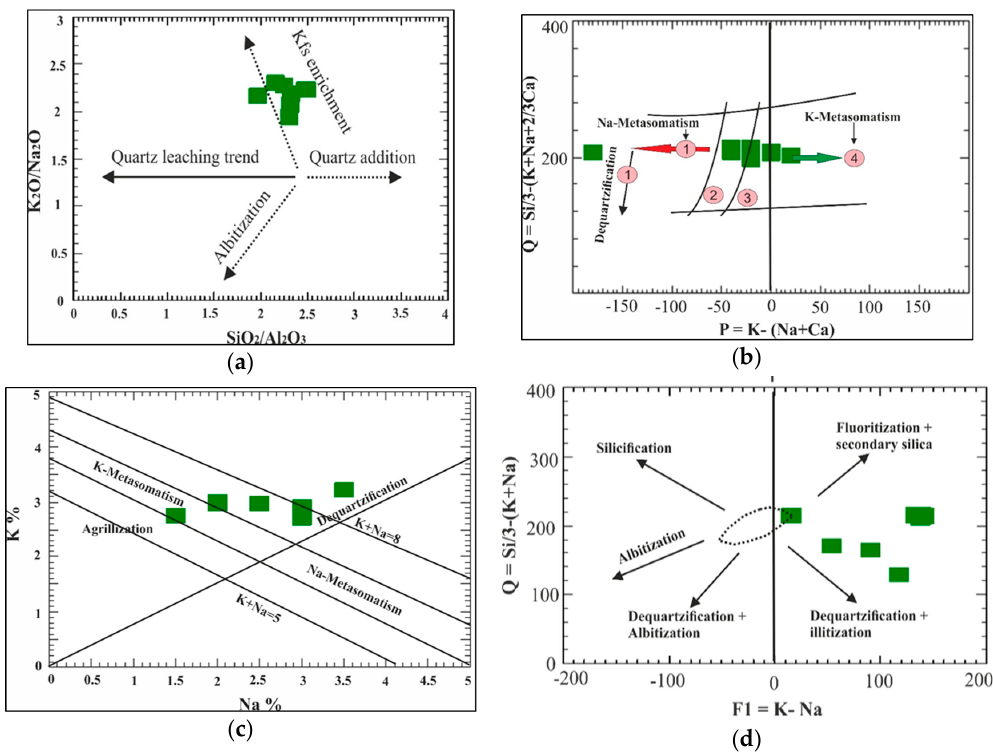
Figure 5. ( a ) K 2 O/Na 2 O versus SiO 2 /Al 2 O 3 binary diagram plots for the studied altered granite [34]. ( b ) Q-P diagram of Cunny et al. (1989) [35]. ( c ) Na-K diagram of Cunny et al. (1989) [35]. ( d ) Q1 vs. F1 binary diagram plots for the studied altered granite [36].